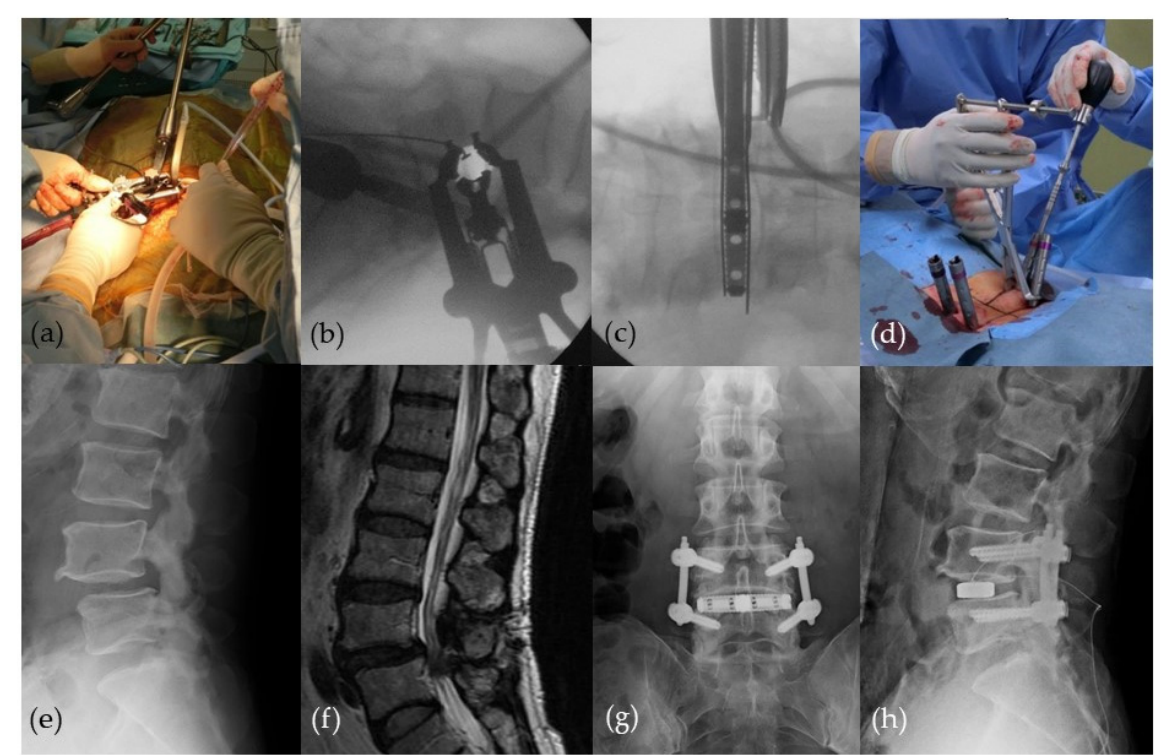
Figure 4. Extreme lateral interbody fusion (XLIF) combined with percutaneous pedicle screw (PPS) fixation. ( a – c ) Intraoperative images of XLIF; ( d ) intraoperative image of PPS; ( e , f ) preoperative im- ages; ( g , h ) postoperative plain radiographs.